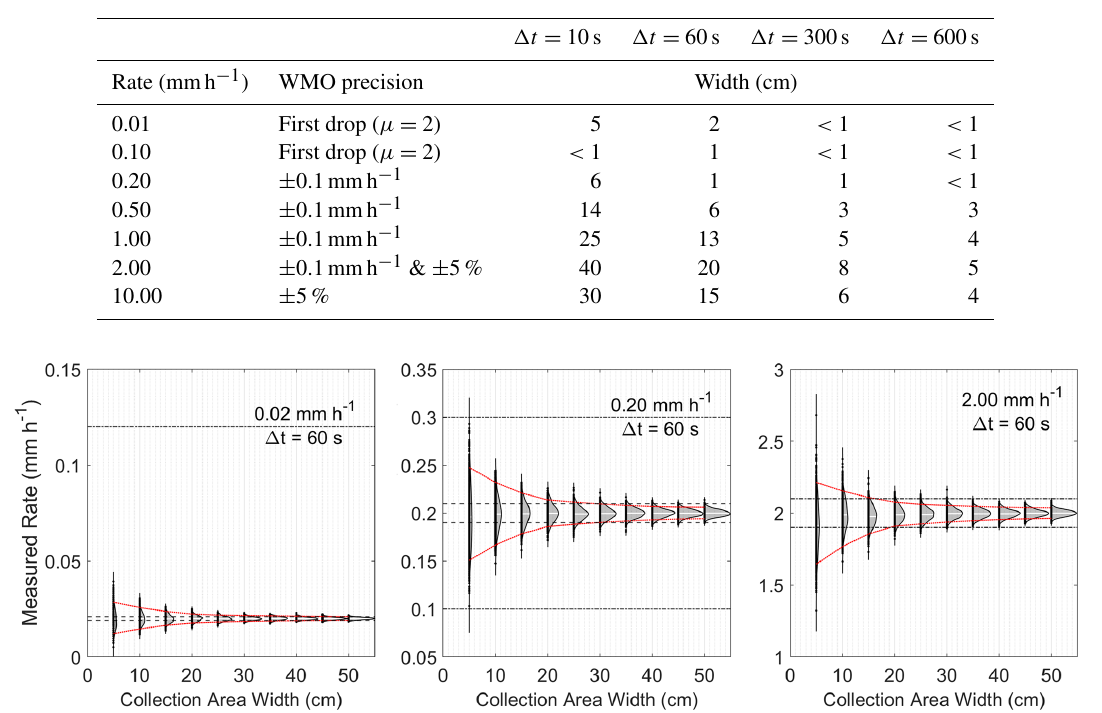
Figure 2. Precipitation rate R calc calculated 1000 times for each W with a uniformly distributed random selection of particle sizes from the Marshall–Palmer distribution with diameters up to 6mm for (cid:49)t = 60s. Vertical curves represent a probability density function (PDF) of calculated R calc with the widths scaled according to the widest curve; 95th and 5th percentile bounds are smoothed and shown in red, dotted lines. WMO standards ( ± 5%, dashed, and ± 0.1mmh − 1 , dot-dashed) are shown as horizontal lines. The intersection of these lines indicates the required square disdrometer sampling area width to determine R according to WMO